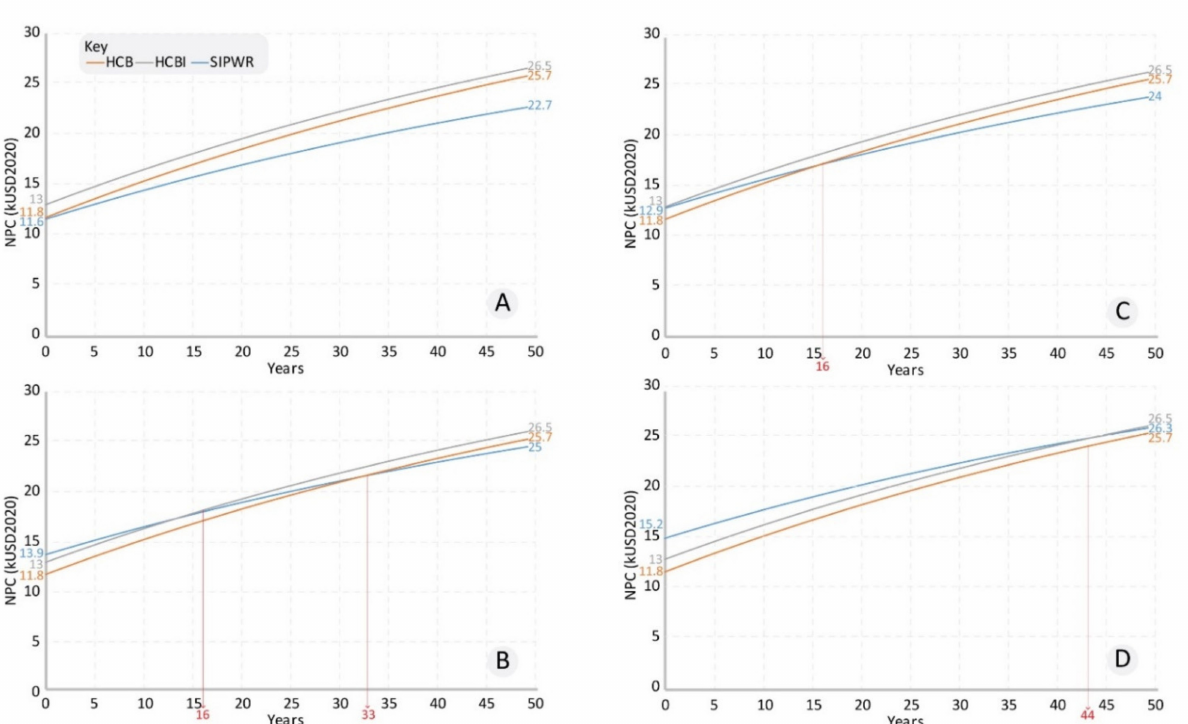
Figure 8. ( A ) LCC across the Hollow Core Block (HCB), Hollow Core Block-Insulated (HCBI) and Structural Insulated Panel Wall (SIPWR) types for the SHLCL12 model; ( B ) LCC across the HCB, HCBI and SIPWR types for the SHLCL17 model; ( C ) LCC across the HCB, HCBI and SIPWR types for the SHPRO12 model; ( D ) LCC across the HCB, HCBI and SIPWR types for the SHPRO17